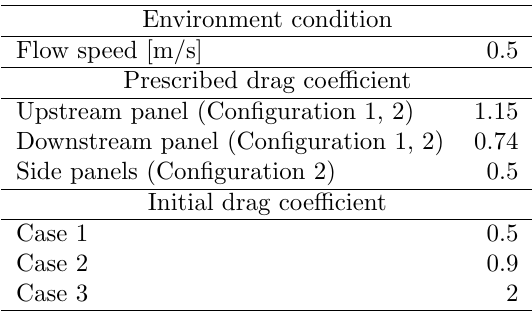
Table 3: Convergence study